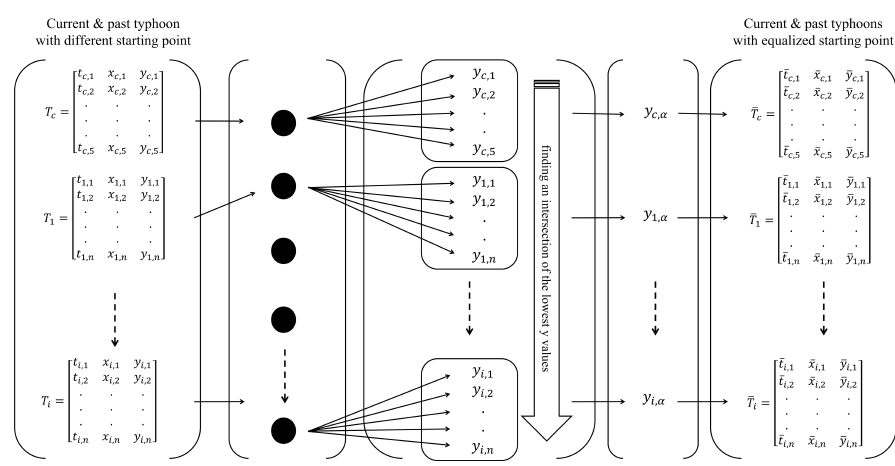
Figure 4. Equalization of starting points for past and sample (current) typhoons.